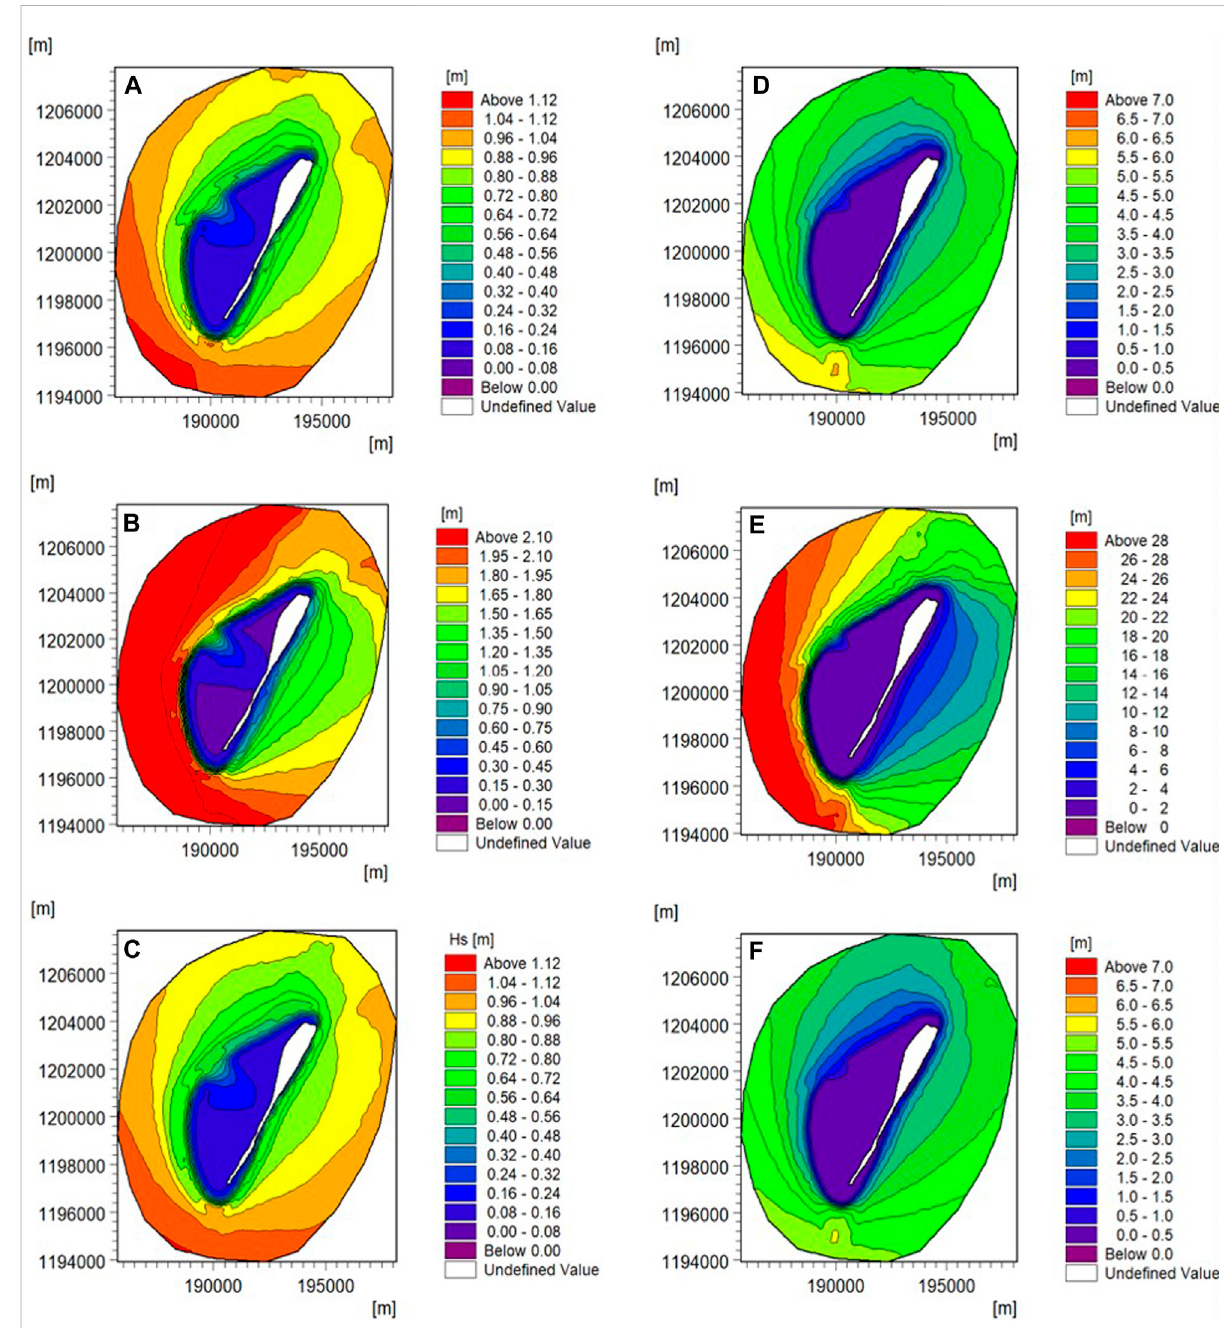
FIGURE 12 (left panel) Spatial distribution of mean signi fi cant wave height around the island (A) Pre monsoon (B) Monsoon (C) Post monsoon; (right Panel) Spatial distribution of annual averaged wave power fl ux for (D) Pre monsoon (E) Monsoon (F) Post